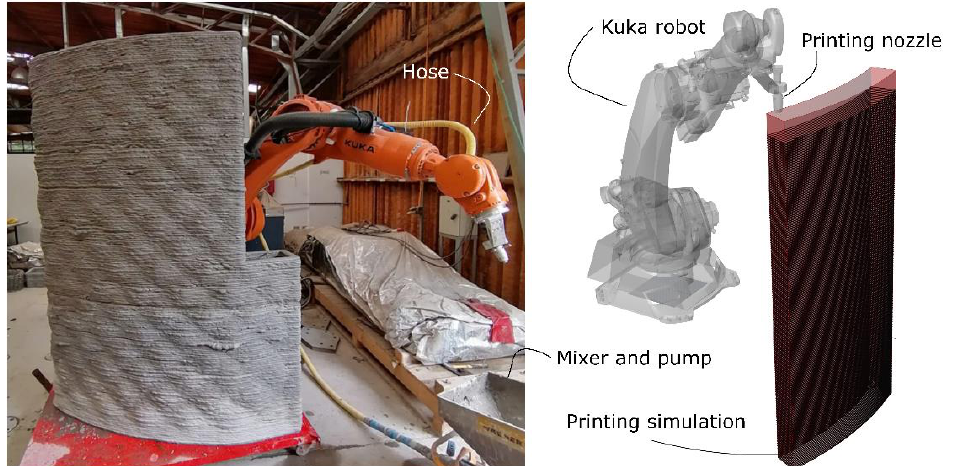
Figure 9. 3D-printed wall prototype executed (left) and previous simulation of the process (right) (Source: authors).